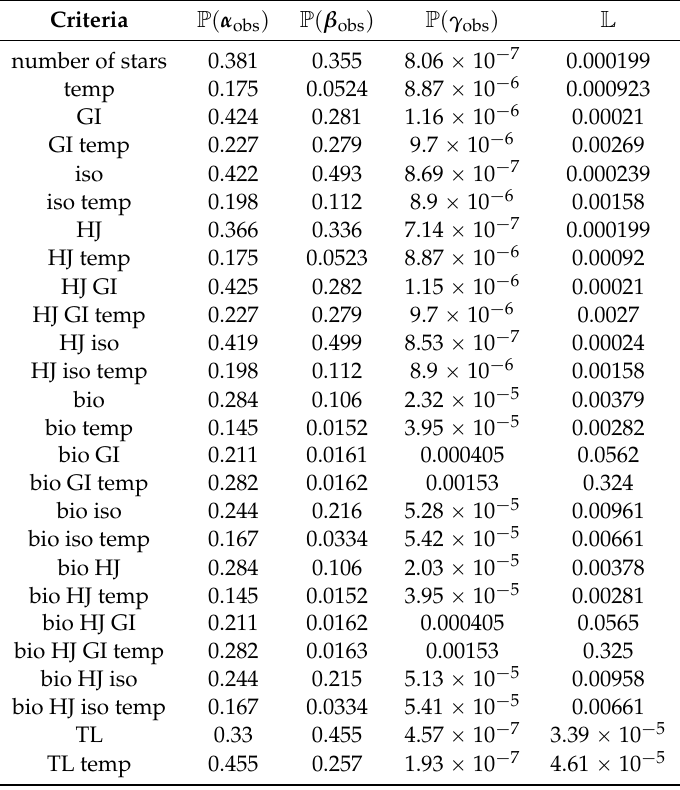
Table 5. Probabilities of various hypotheses, including those from [1] (continued on following pages). In addition to the abbreviations from Table 4, the shorthand is: photo: photosynthesis (optimistic), yellow: photosynthesis (conservative), TL: tidal locking, bio: biological timescale, S: entropy, temp: temperate zone, GI and iso: terrestrial planet with giant impact and isolation production mechanisms, resp. and HJ: hot